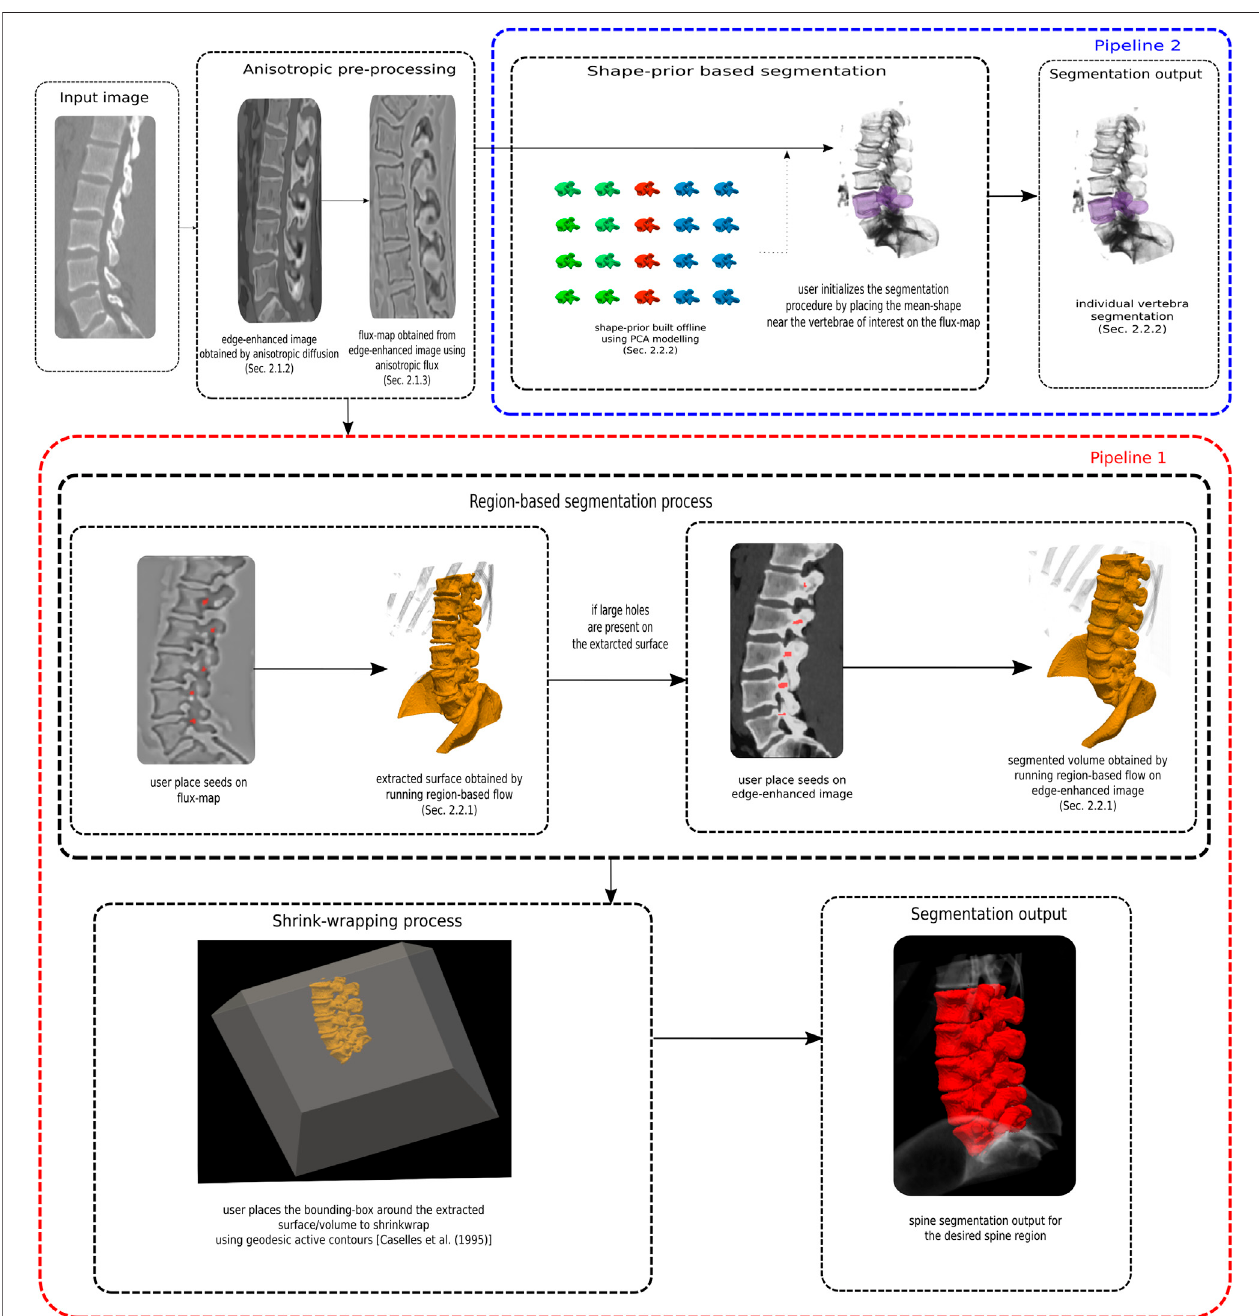
FIGURE 5| A fl owchart summarizing the two segmentation pipelines. In pipeline one, a number ofvertebrae are segmented together asa single spine object, with no training data required, but with manual identi fi cation of seed in a vertebrae. In a separate second pipeline, a shape prior is coupled with a fl ow to segment individual vertebrae. For this part some ground truth data is required to build the